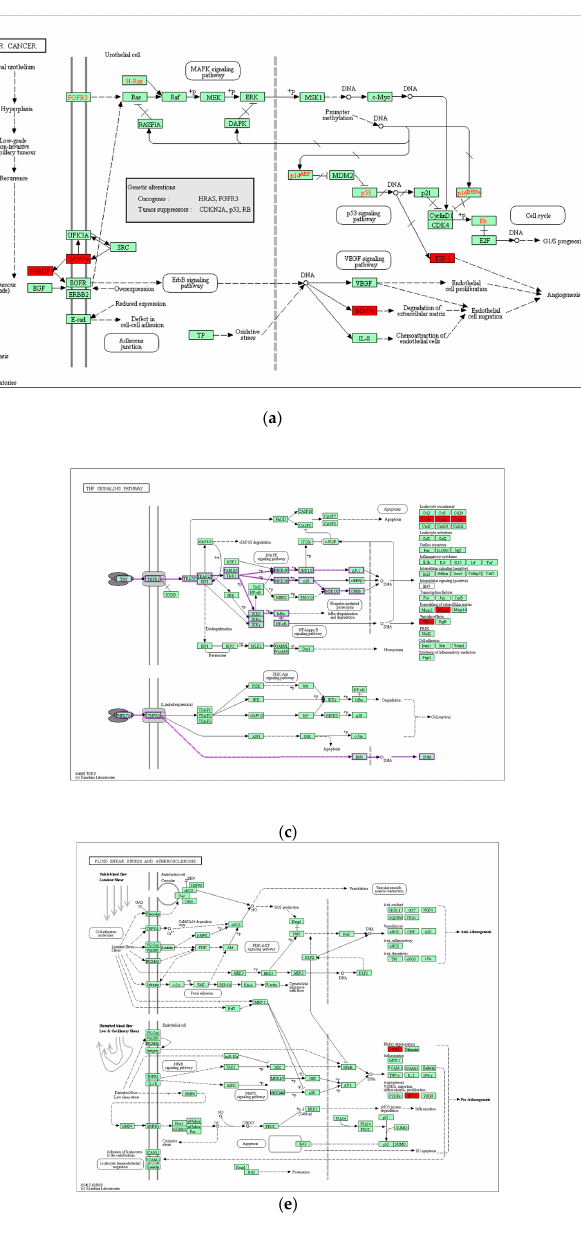
Figure 5. The Kyoto Encyclopedia of Genes and Genomes pathway of differentially control capability genes. Red diamonds represent the DCCGs in AMI. ( a ) Bladder cancer. ( b ) Transcriptional misreg- ulation in cancer. ( c ) TNF signaling pathway involved in MMP9 , EDN1 , and CXCL3 . ( d ) Relaxin signaling pathway. ( e ) Fluid shear stress and